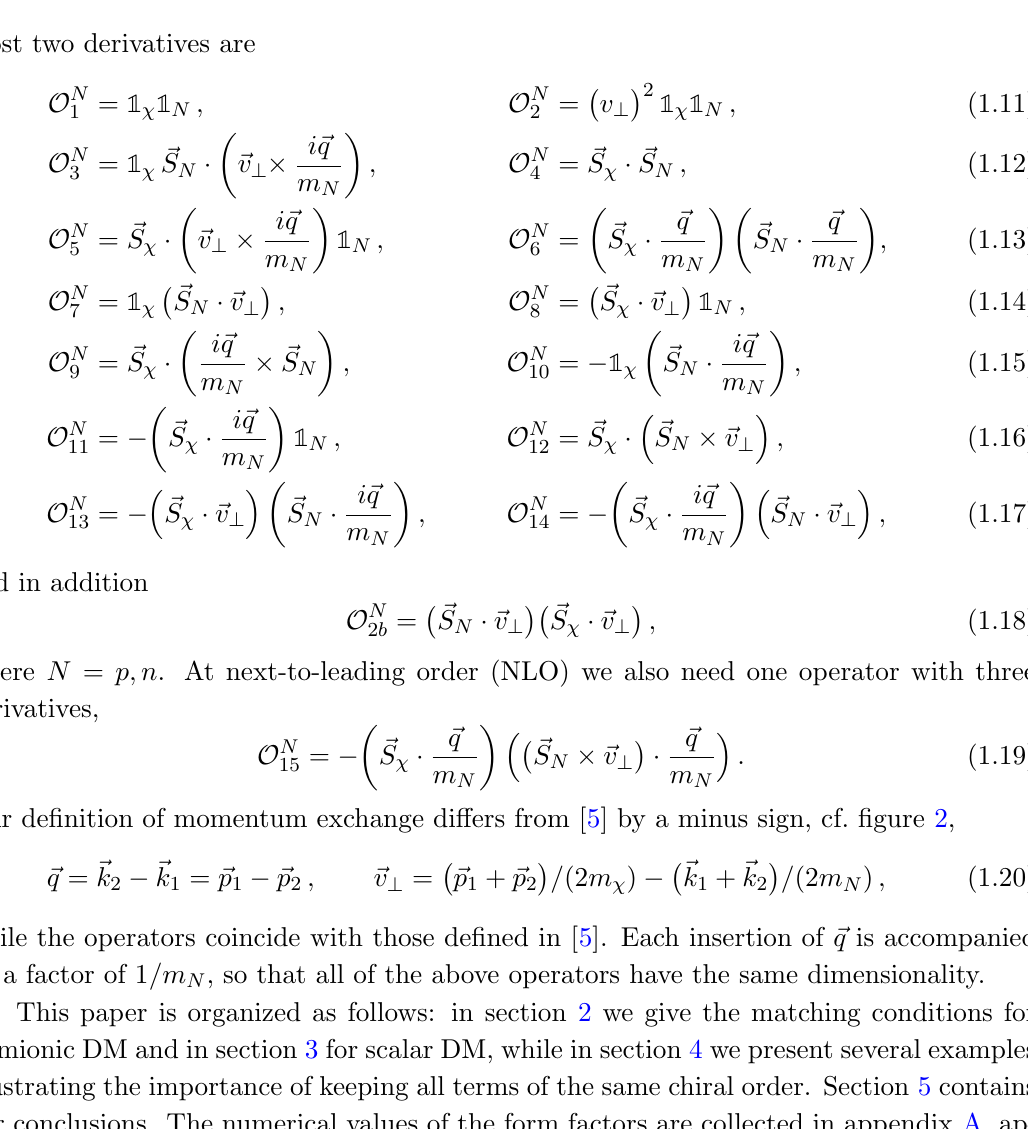
(cid:31) ( p 2 ) N ( k 2 ). !